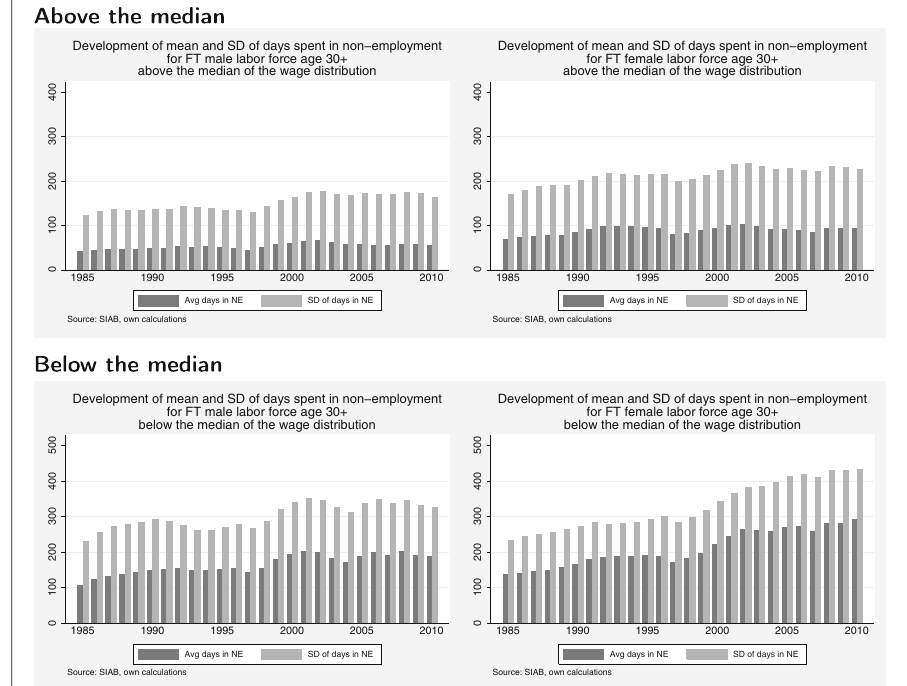
Fig. 17 Days spent in nonemployment during the last 5 years (full-timers aged 30-60